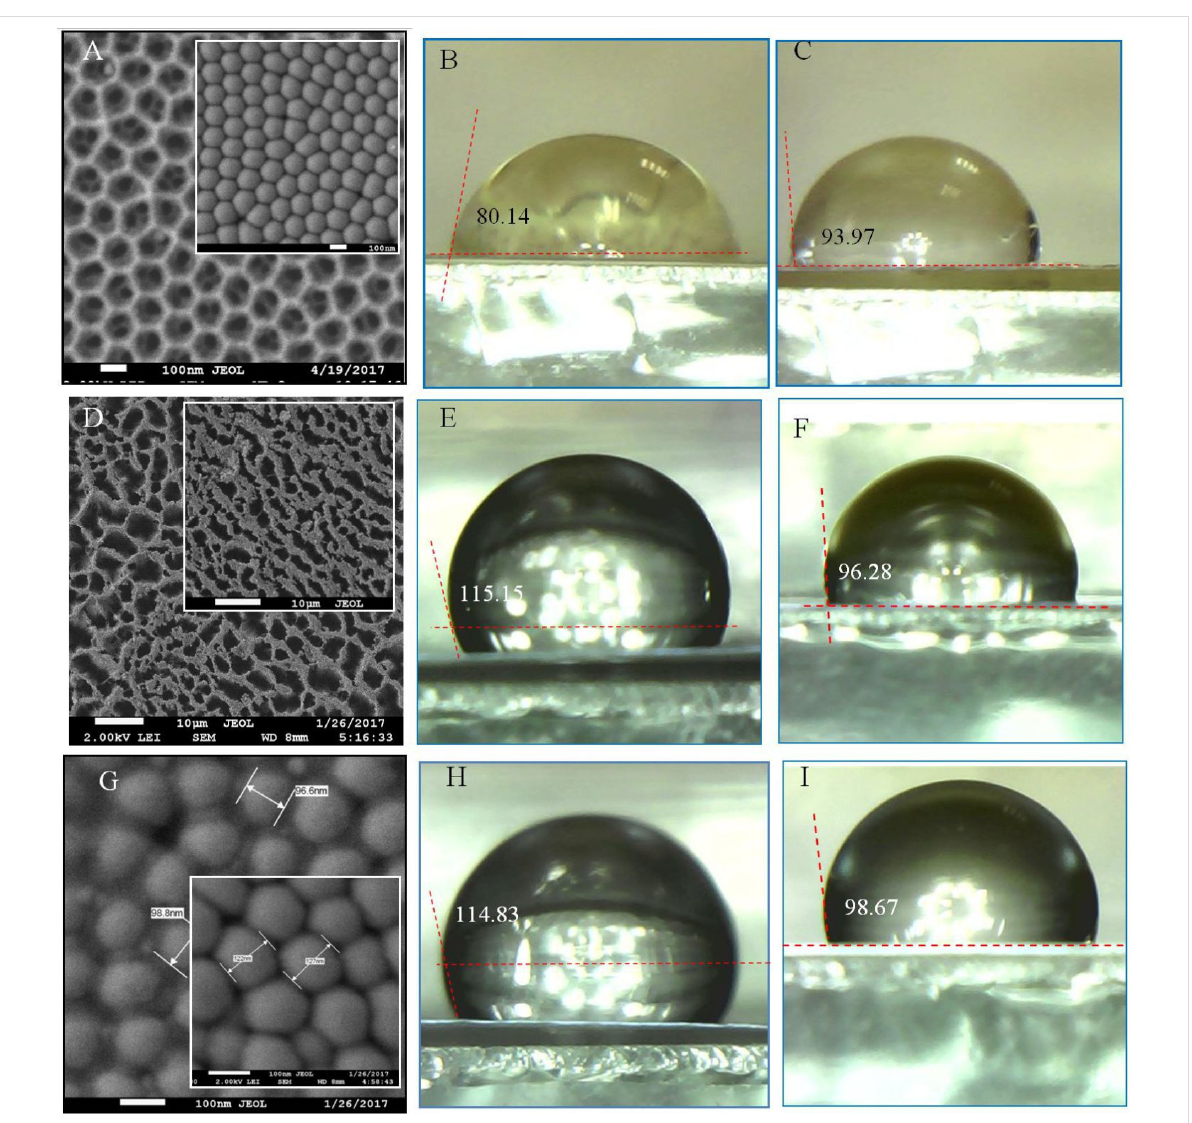
Figure 10: Contact angle as a function of surface topology (middle column images (B, E, H) are outer surfaces and right-hand column images (C, F, I) are back surfaces) for a PAM synthesized using type I synthesis conditions. (A–C) As-synthesized PAM; (D–F) sample 3. (A, D) SEM images of outer and back (inset) surfaces of these samples. (G) SEM images of the back side and the contact angle for the back side of a PAM (type I) before (inset) and after 7 min of chemical etching before pore